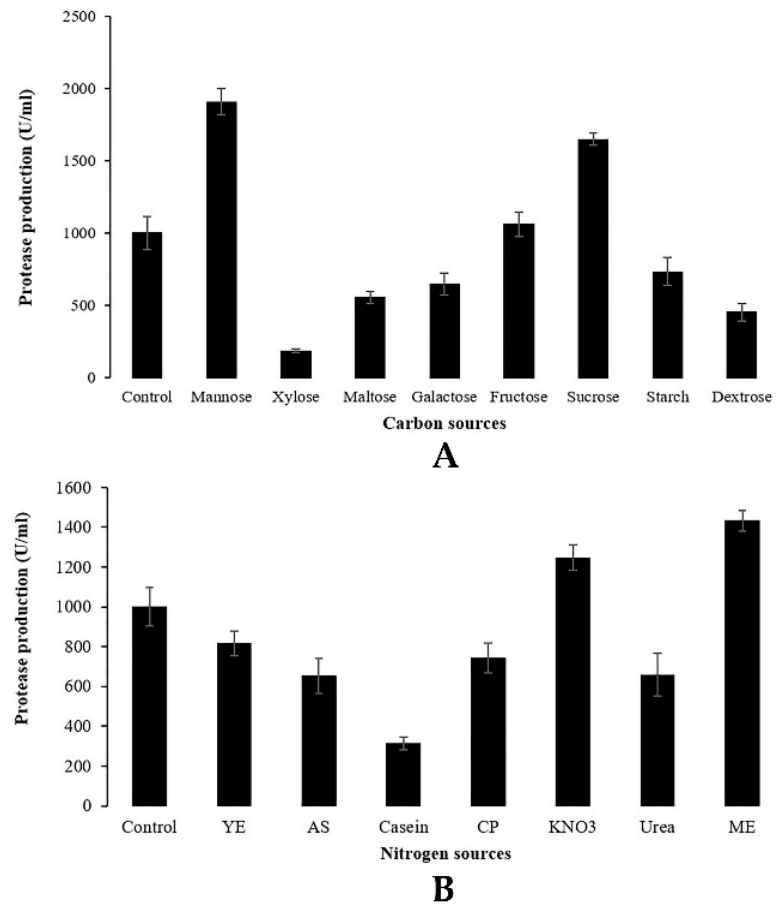
Figure 3. Effect of various sources of carbon ( A ) and nitrogen ( B ) on protease production using C/N ratio. YE yeast extract, AS ammonium sulfate, CP casein peptone, ME malt extract.